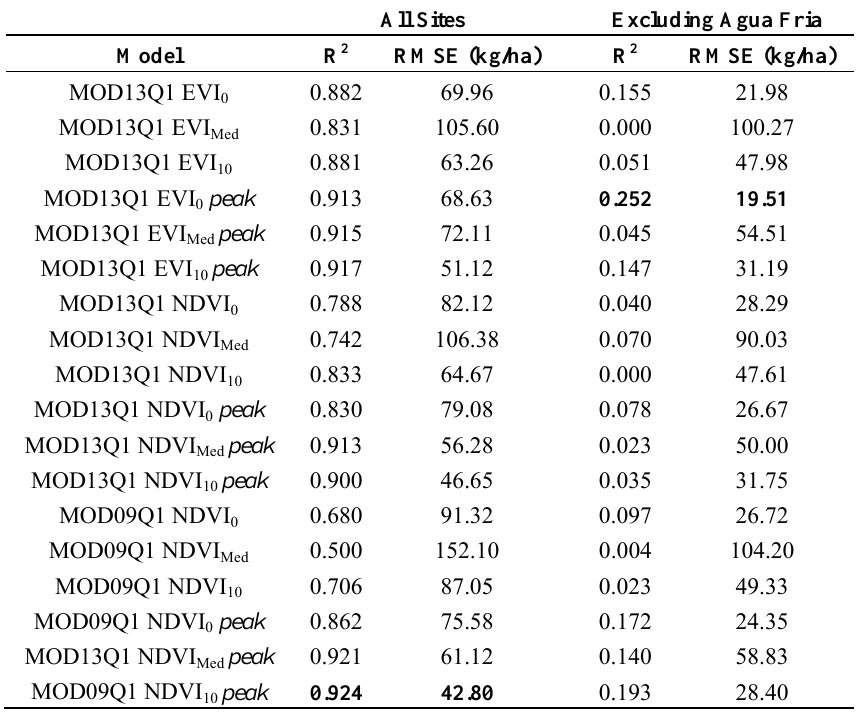
Table 2. Goodness of fit statistics for the 18 models compared in order to determine the best method of predicting winter annual biomass from MODIS time-series data. The first set of parameters are calculated using all five field sites, and the second are calculated excluding the Agua Fria site, which was the most productive of the five sites. Bolded models indicate goodness of fit metrics for models providing the best fit, as discussed in the